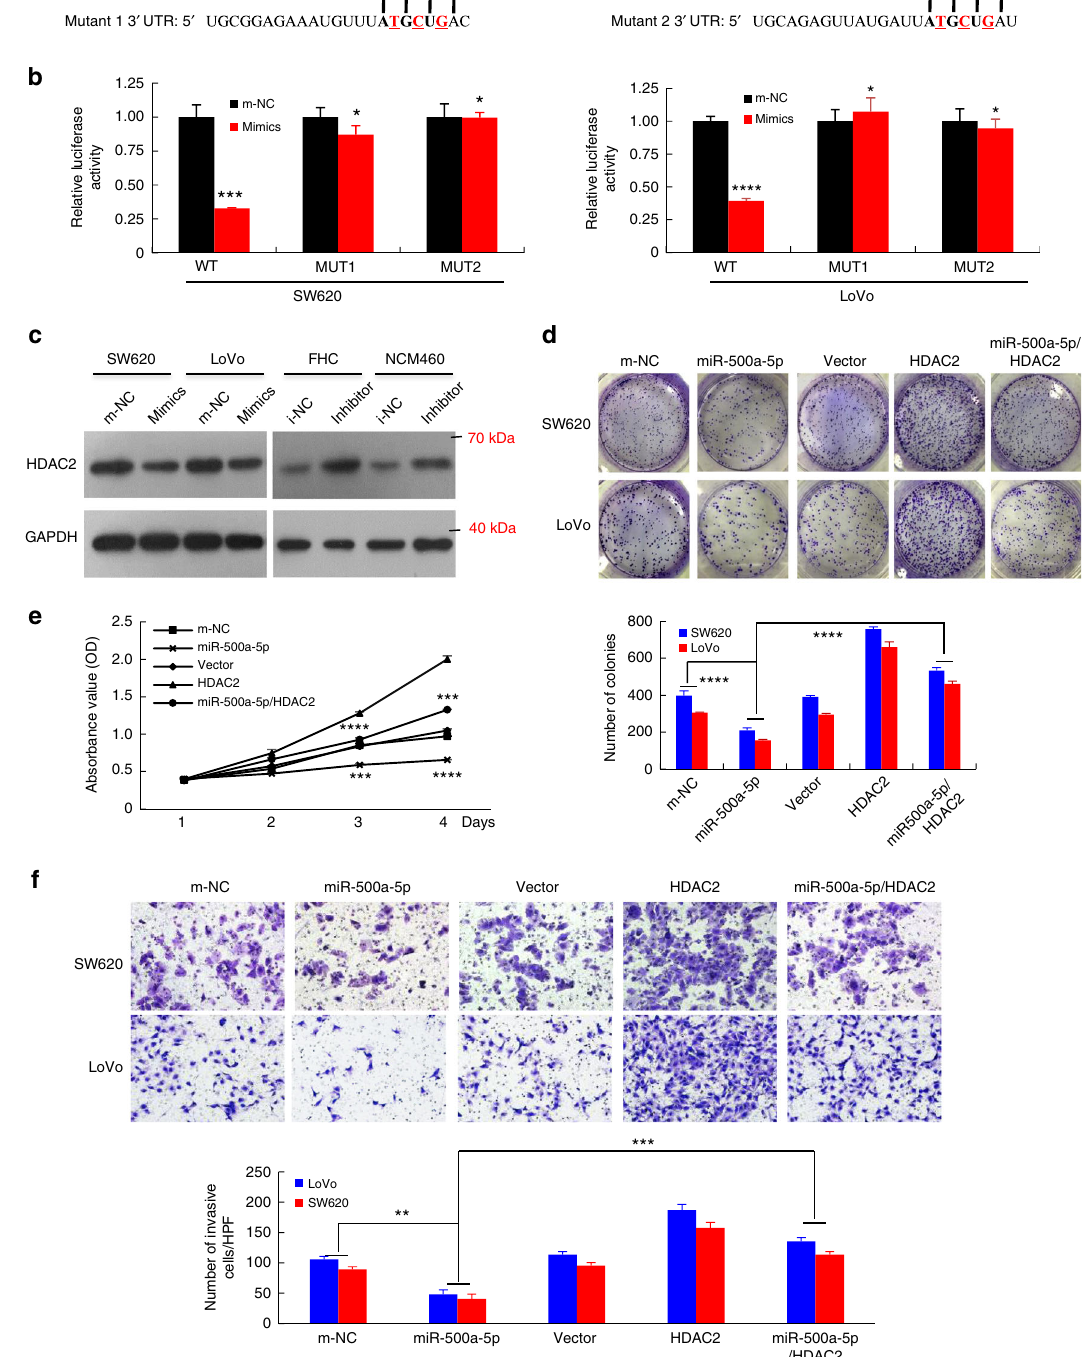
Wild-type 3 ′ UTR 5 ′ (site 1: 4703–4709) hsa-miR-500a-5p: 3 ′ Mutant 1 3 ′ UTR: 5 ′